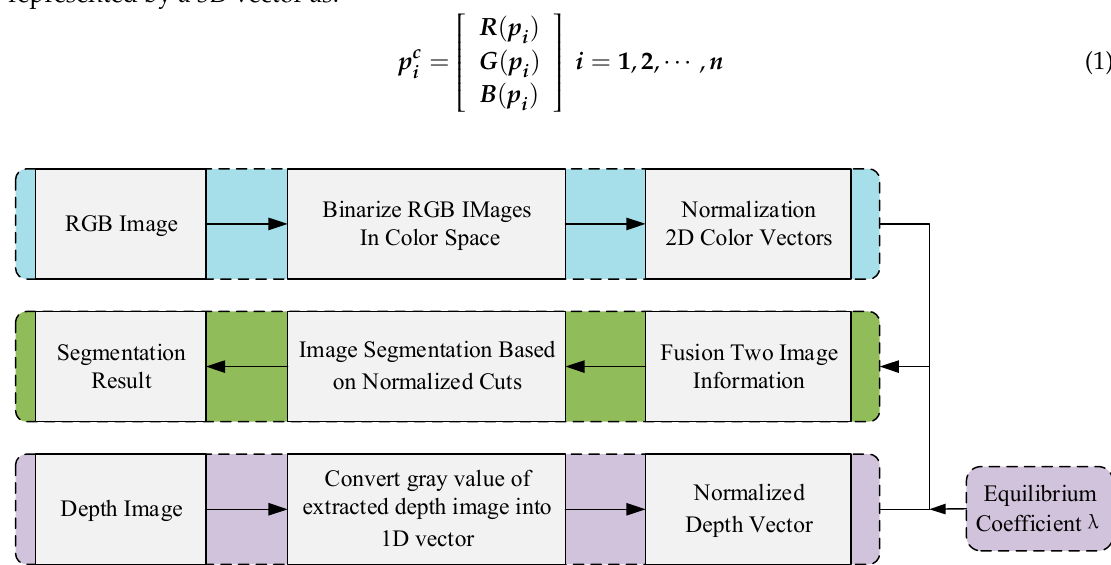
Figure 2. Composition of the proposed scene segmentation algorithm of RGB-D image.